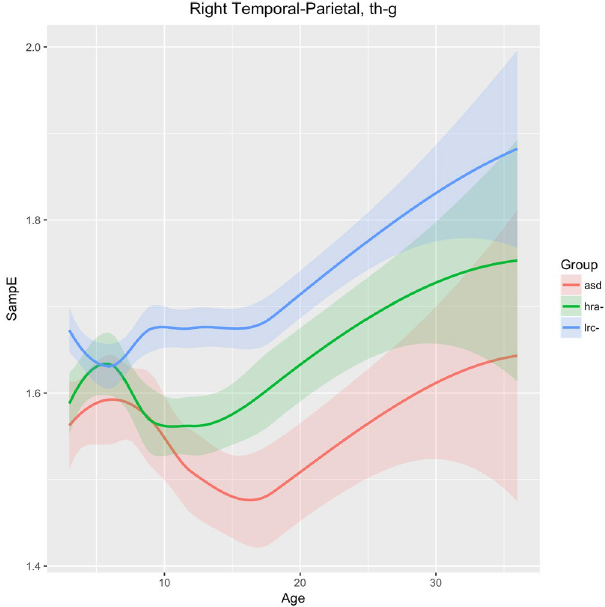
Figure 9. Developmental trajectories for SampE in the right temporal-parietal region (T8 + P4 + P8 sensors) in frequencies theta through gamma for ASD, LRC − , and HRA − .